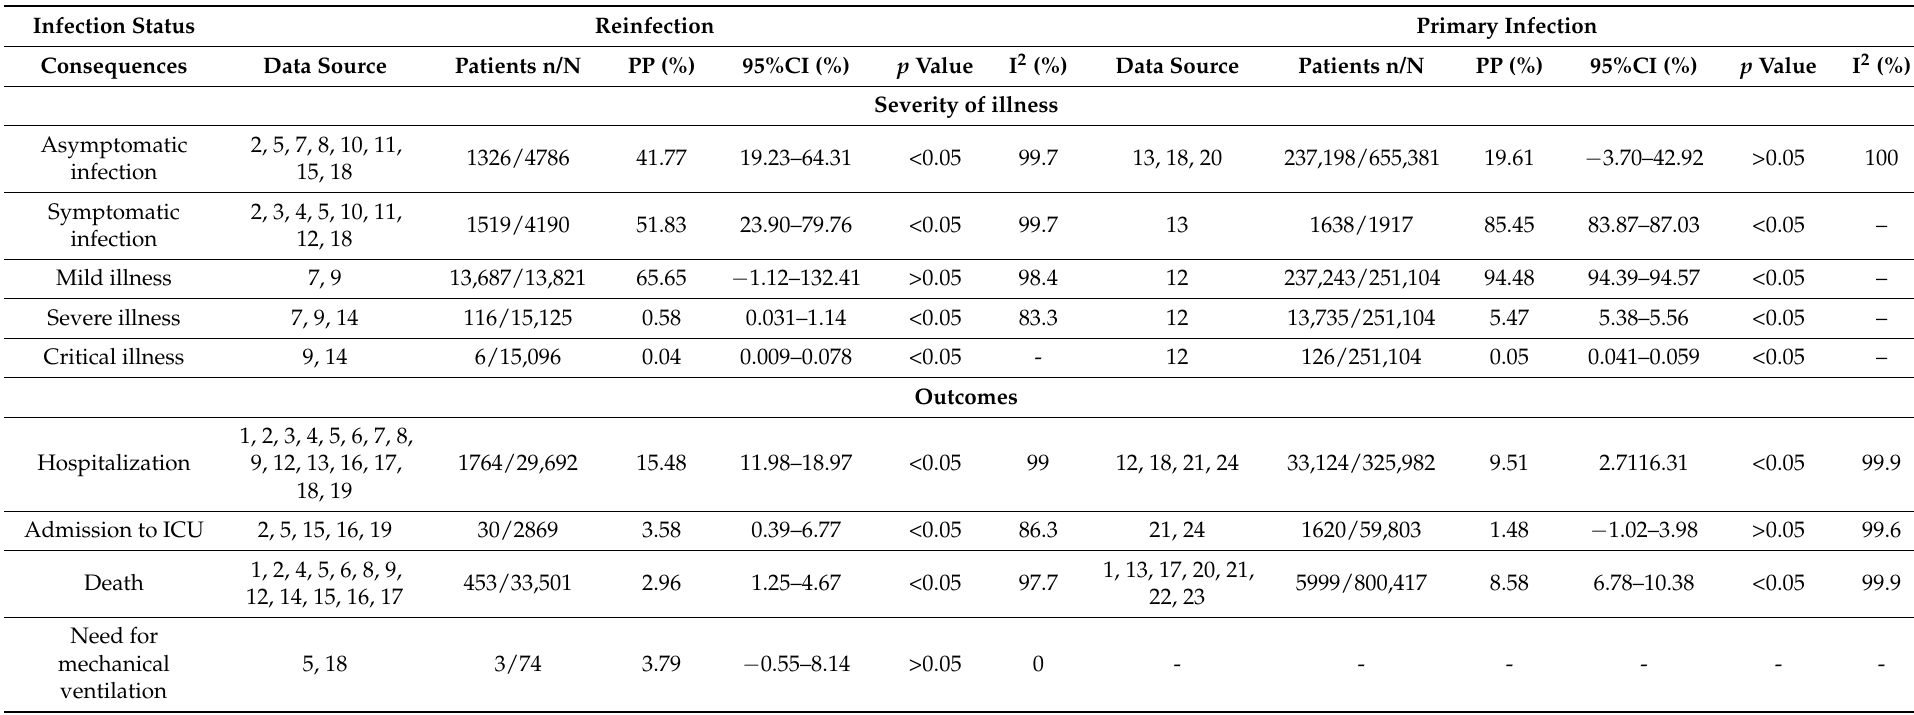
Table 1. Pooled prevalence (PP) of severity of illness and outcomes of SARS-CoV-2 reinfection and primary